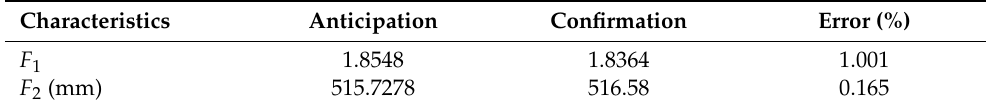
Table 8. Error between anticipated results and verifications. Characteristics